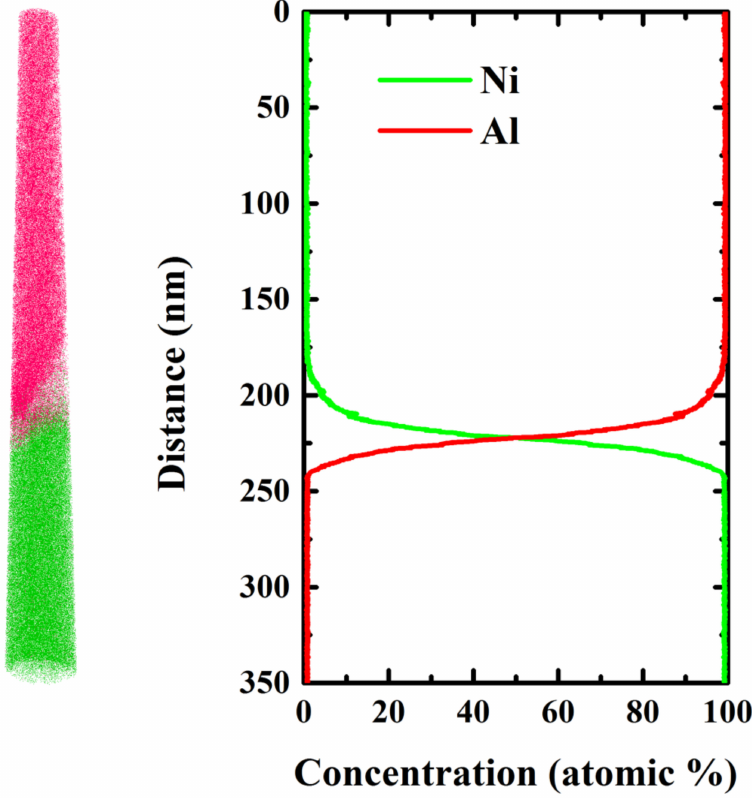
Figure 9. Reconstruction of atomic distribution and concentration profiles of the as-deposited Al/Ni